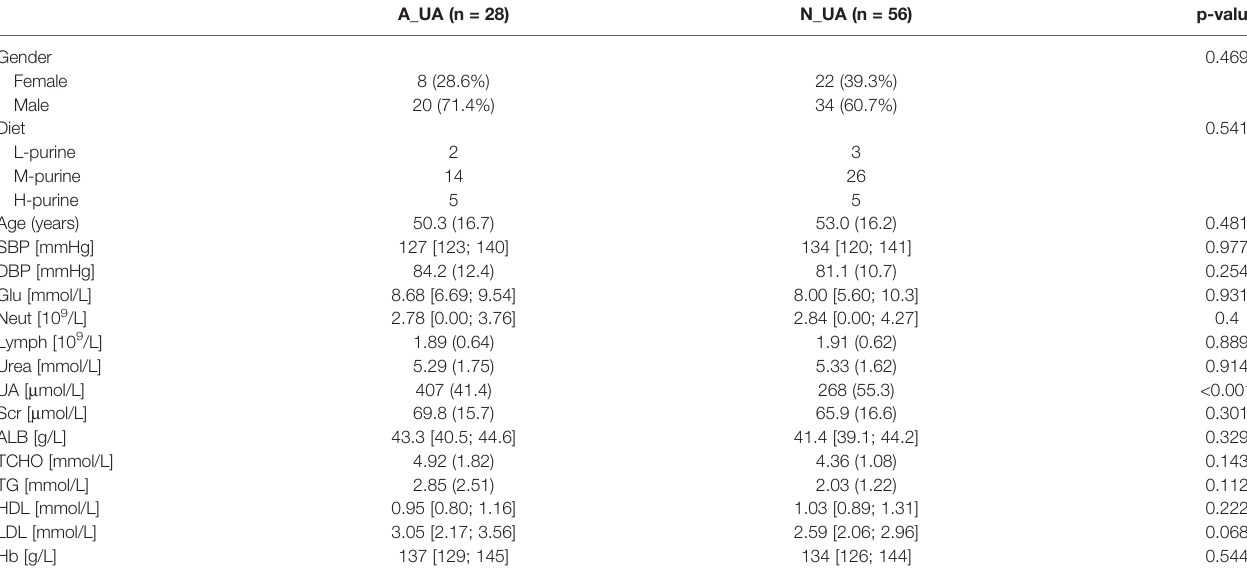
TABLE 2 | Population characteristics of 1:2 matching between normal uric acid and abnormal uric acid group. A_UA (n = 28) N_UA (n = 56) p-value Gender